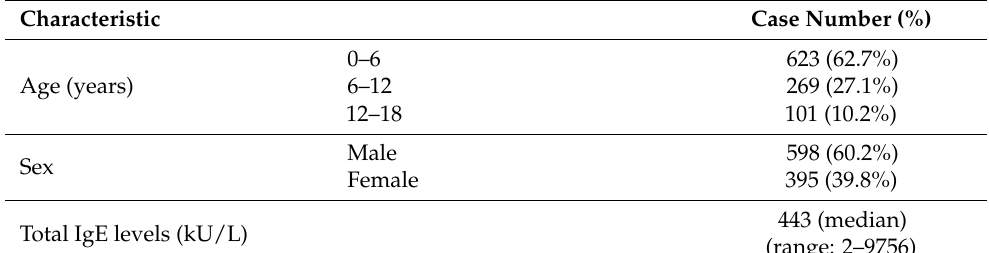
Table 1. Distribution of age, sex, total serum IgE levels, and 36 allergen-specific IgE.